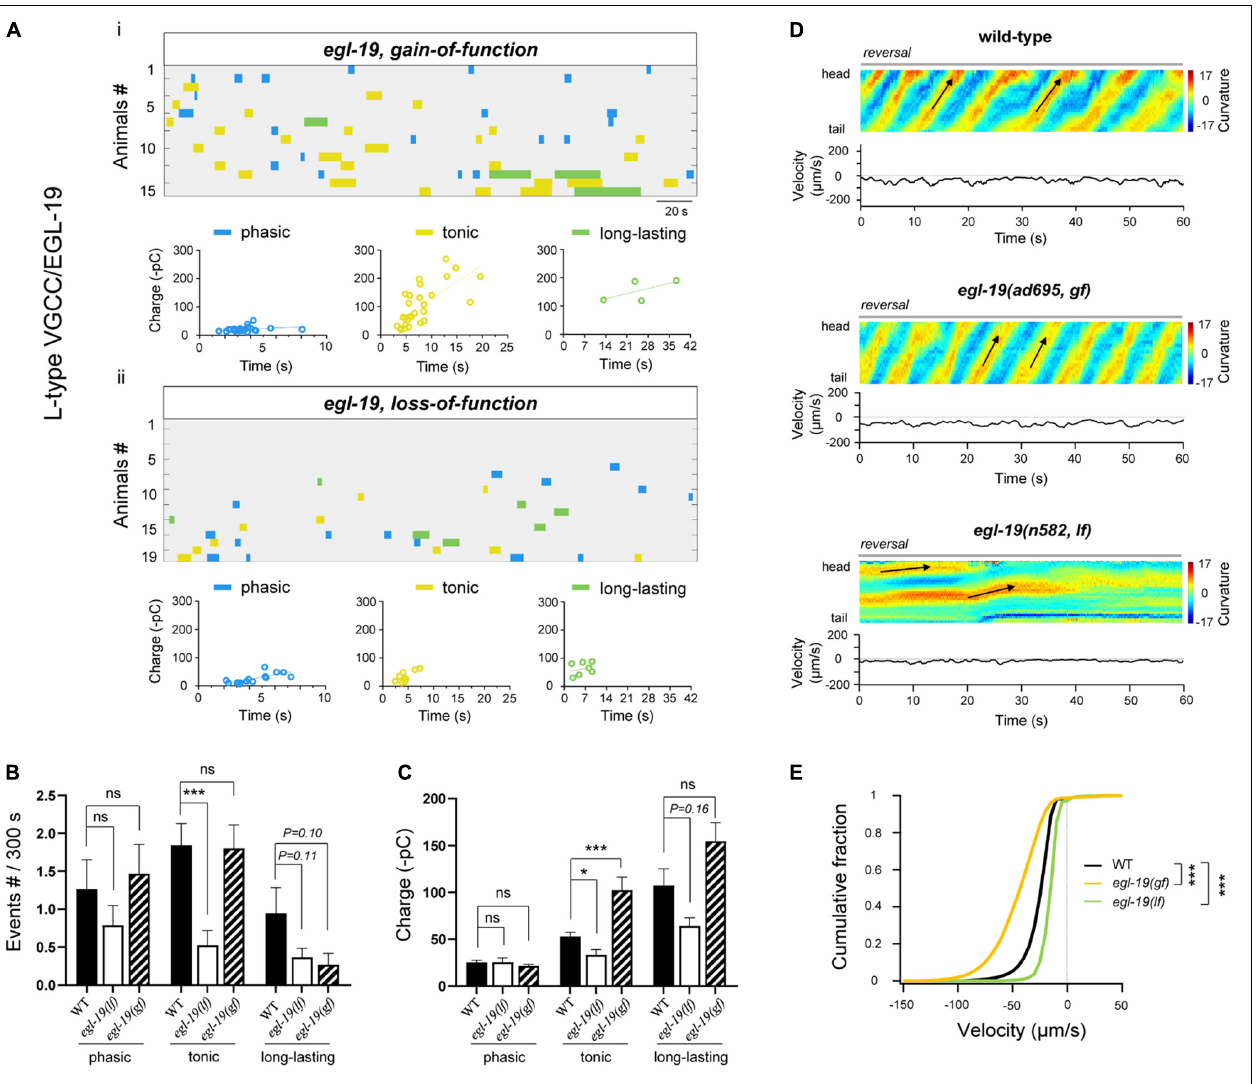
FIGURE 4 | High-voltage L-VGCC (EGl-19) specifically regulates tonic-rPSCs. (A) Colormap and charge efficiency (linear fitting) of all rPSC events from egl-19(ad695; gf) and egl-19(n582; lf) mutant animals, after the coablation of premotor INs and B-MNs. Blue dots denote phasic-type events, yellow dots denote tonic-type events, and green dots denote long-lasting-type events. (B,C) Quantification of the frequency and charge of different rPSCs in respective genotypes with premotor INs and B-MNs ablation. n ≥ 16 animals in each group. (D) Representative curvature kymogram ( up ) and instantaneous velocity ( bottom ) of free-behaving animals of respective genotypes after ablation. e gl-19(ad695; gf) mutants exhibit increased reversal, as posterior to anterior propagating body bends (arrows). egl-19(n582; lf) mutants exhibit reduced backward locomotion. (E) Distribution of instantaneous velocity of wild-type, e gl-19(ad695; gf) and egl-19(n582; lf)